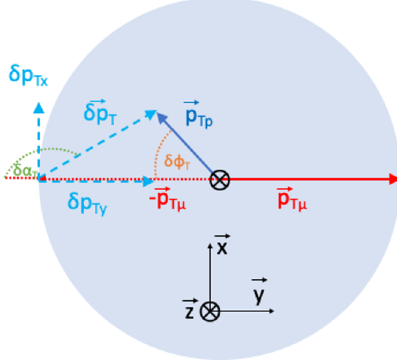
, δp ) in a reference T Y X